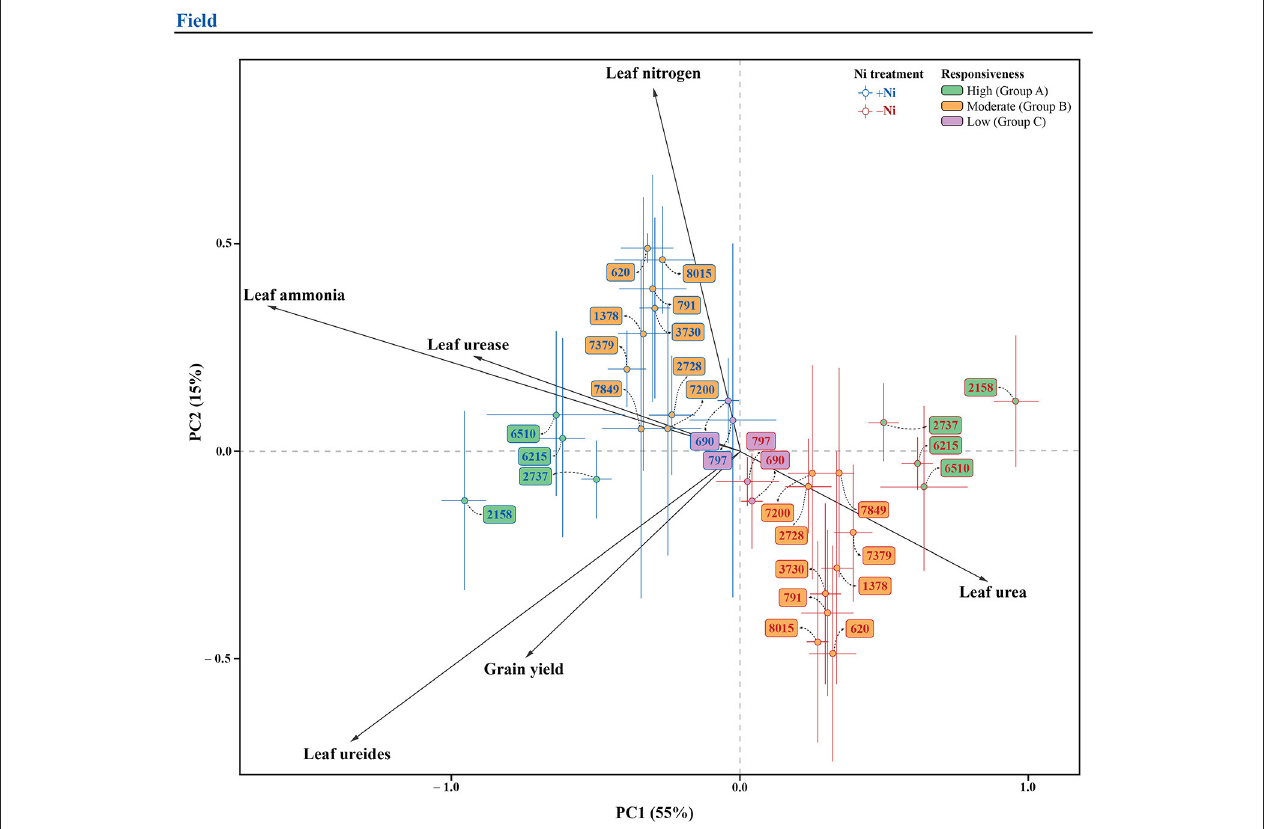
FIGURE 5 | Biplot of the partial principal components analysis of variables related to N metabolism, leaf N concentration and grain yield for 15 soybean genotypes, fertilized with 0.0mg of Ni kg − 1 ( − Ni) and 0.5mg of Ni kg − 1 ( + Ni), cultivated in field condition. In the figure, genotypes are divided into three groups according to responsiveness of N metabolism to Ni fertilization: Group A, high; B, moderate; and C,